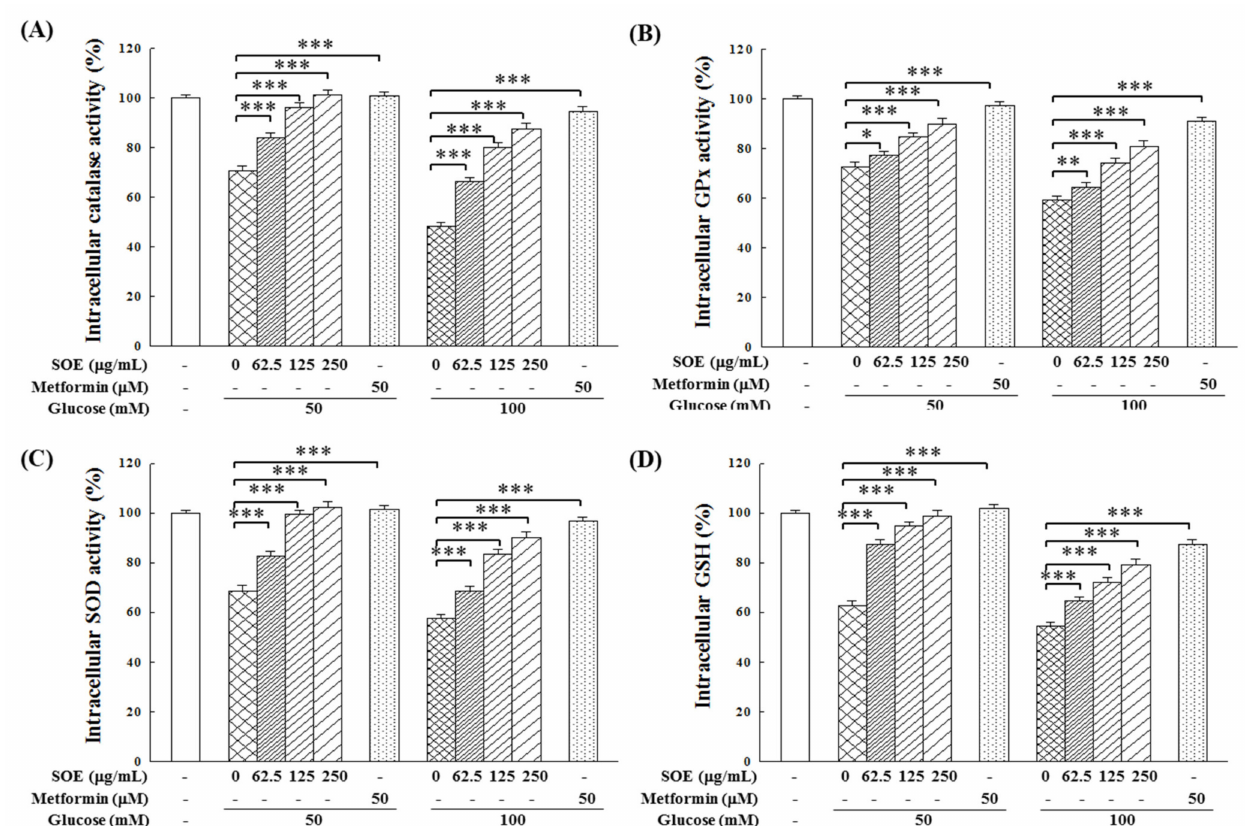
Figure 3. Effect of SOE on the production of antioxidant enzymes and GSH in RIN-m5f β -cells under HG induction. ( A ) catalase, ( B ) GPx, ( C ) SOD, and ( D ) GSH. The β -cells were cultivated in 6-well plates at a density of 5 × 10 5 cells/well for 24 h, and the indicated concentration of SOE was added under the stimulation of 50 mM or 100 mM glucose. After 24 h treatment, the cell extracts were prepared according to the manufacturer’s instruction. The protein content was measured using the Bicinchoninic Acid Protein Assay Kit. The assay of the activities of catalase, GPx, SOD, and the content of GSH were performed according to manufacturer’s instructions with Sigma-Aldrich Assay Kits. The experimental data were calculated from the results of three repeated experiments. The statistically significant differences compared with the vehicle (group 0) are expressed as * p < 0.05, ** p < 0.01, and *** p < 0.001. The positive control was 50 µ M